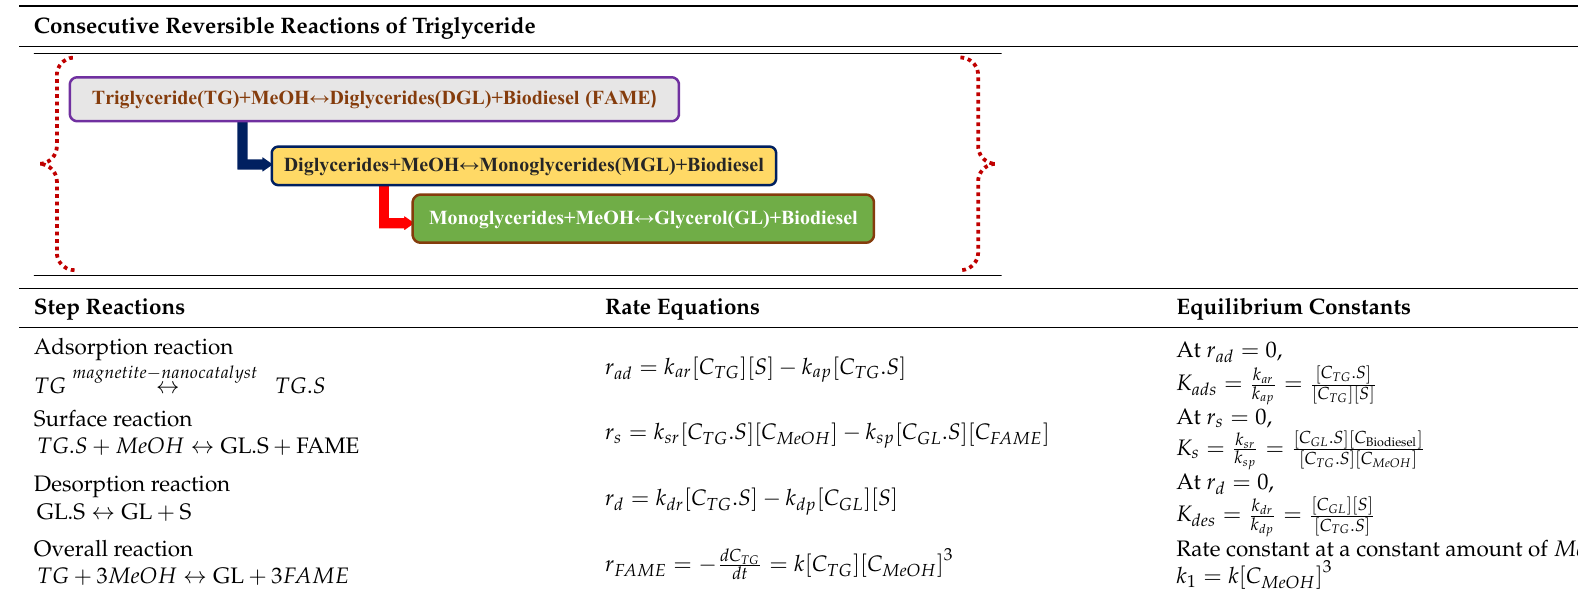
Table 4. Catalytic transesterification reactions.